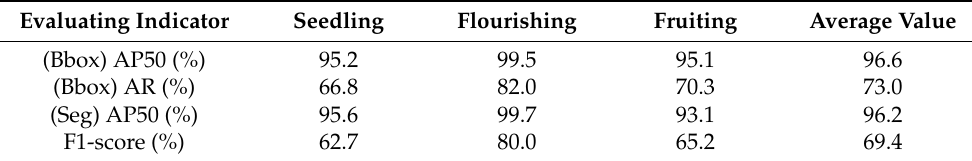
Table 4. Instance segmentation performance test results of MSEU R-CNN